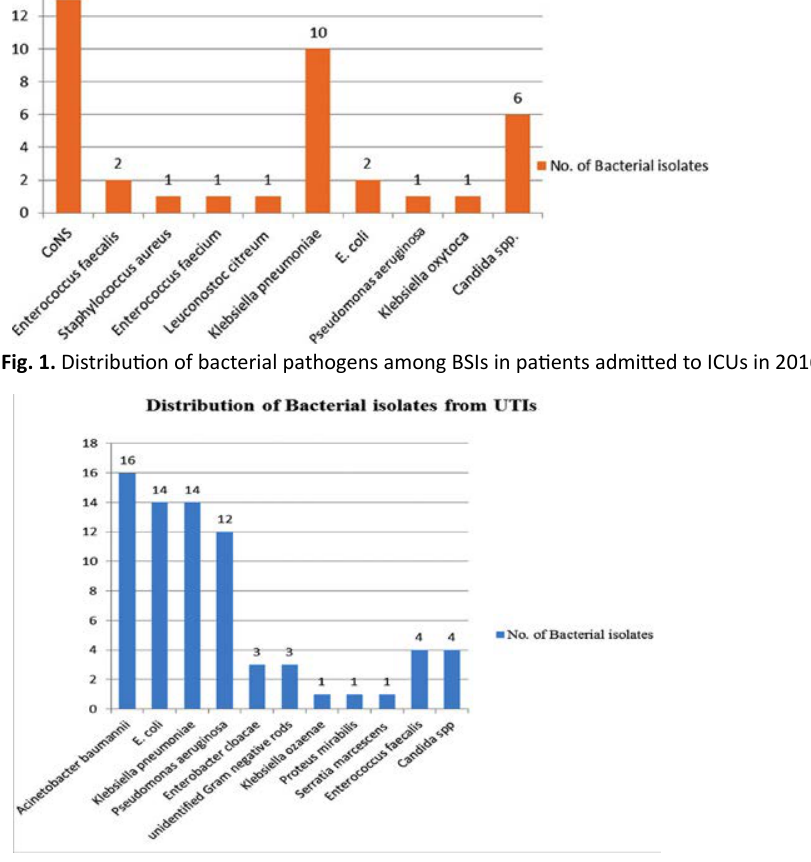
Fig. 2. Distribution of bacterial pathogens among UTIs in patients admitted to ICUs in 2016 &